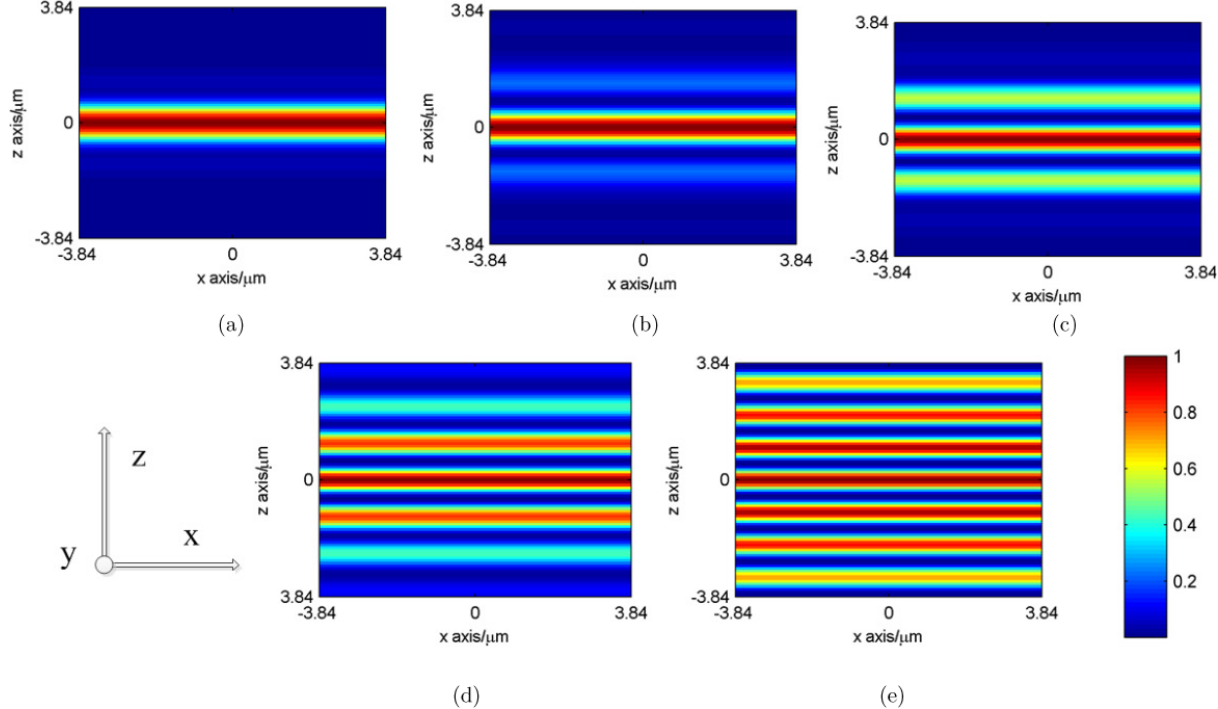
Fig. 3. (a) – (e) The multiple light sheets of D-aperture combined scanning processing for di®erent factors of d / r . The factor of d / r is equal to 0, 0.4, 0.8, 1.2 and 1.6.